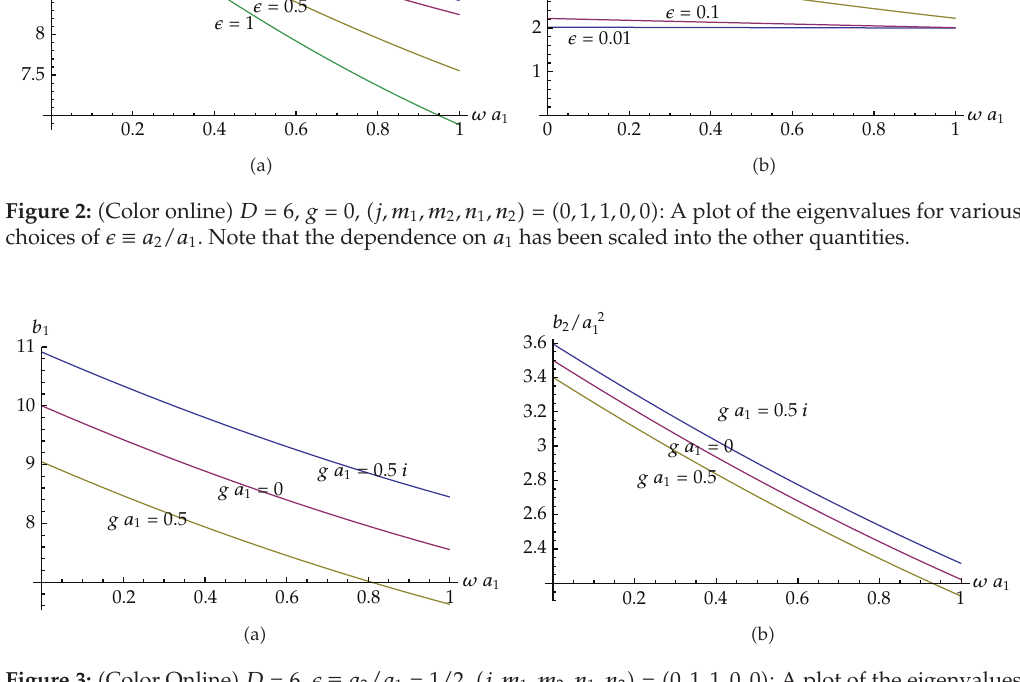
Figure 3: (cid:2) Color Online (cid:3) D (cid:8) 6, (cid:23) ≡ a 2 /a 1 (cid:8) 1 / 2, (cid:2) j,m 1 ,m 2 ,n 1 ,n 2 (cid:3) (cid:8) (cid:2) 0 , 1 , 1 , 0 , 0 (cid:3) : A plot of the eigenvalues for ga 1 (cid:8) 0 . 5 i, 0 , 0 . 5, corresponding to de-Sitter, flat, and anti-deSitter spacetimes respectively. Note that the dependence on a 1 has been scaled into the other